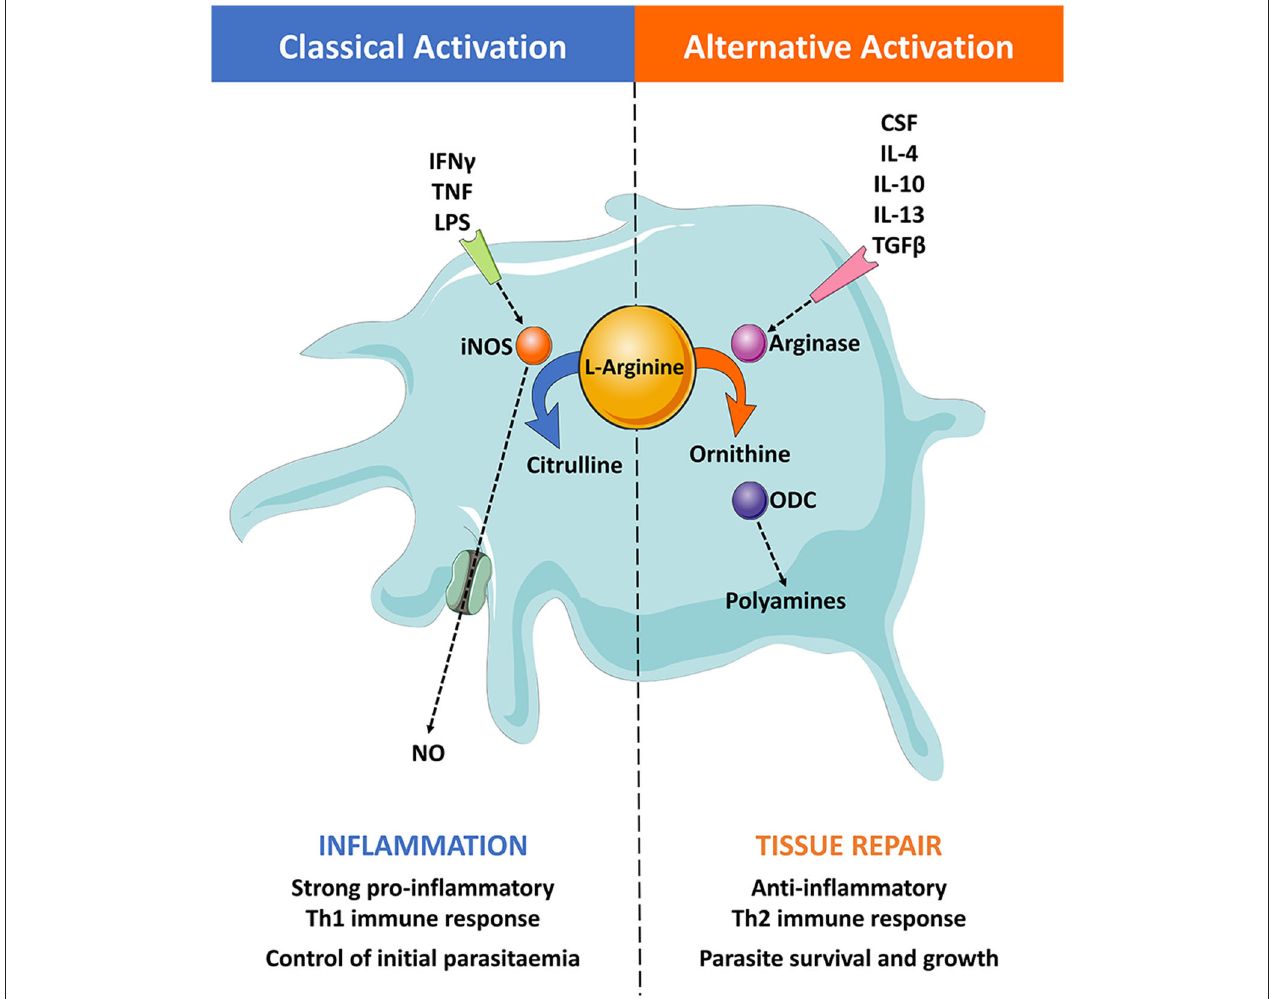
FIGURE 3 | The roles of classically and alternatively activated macrophages. (Left) Pro-inflammatory stimuli, such as IFN- γ , TNF- α , and LPS, classically activates macrophages. Classically activated macrophages induce the expression of the inducible nitric oxide synthase (iNOS) enzyme, which catabolizes the substrate L-arginine to produce NO and citrulline. This results in a pro-inflammatory Th1 immune response that can effectively control the initial parasitaemia peak. (Right) Anti-inflammatory stimuli, such as CSF, IL-4, IL-10, IL-13, and TGF- β , alternatively activate macrophages. These induce the expression of the arginase enzyme that catabolizes the substrate L-arginine to produce ornithine. The enzyme ornithine decarboxylase (ODC) catalyzes the breakdown of ornithine to produce polyamines, resulting in an anti-inflammatory Th2 immune response and tissue repair. This type of response typically leads to an immune environment that promotes trypanosome growth and